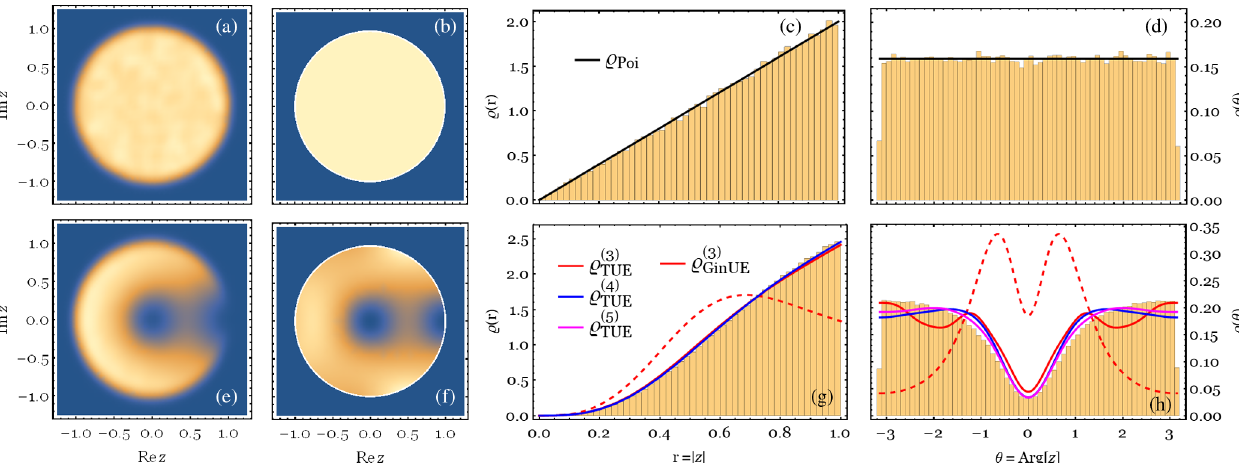
FIG. 3. Distribution of complex level-spacing ratios — numerical results and analytic predictions for independent levels (a) – (d) and GinUE-drawn matrices (e) – (h). (a) Spacing ratio density for 10 5 independently drawn levels. (b) Flat distribution, Eq. (4). (c,d) Histogram of j z j and arg z (yellow bars) and theoretical prediction (black lines). (e) Spacing ratio distribution for GinUE matrices ( N ¼ 10 4 ) obtained by ED. (f) Surmise for the TUE with N ¼ 3 , Eq. (7). (g,h) Histograms of j z j and arg z obtained by ED (yellow bars). Red, blue, and magenta (solid) lines computed from Eq. (C9) for N ¼ 3 , 4, 5, respectively; dashed lines give the exact N ¼ 3 result from the GinUE, Eq. (C7), for comparison.